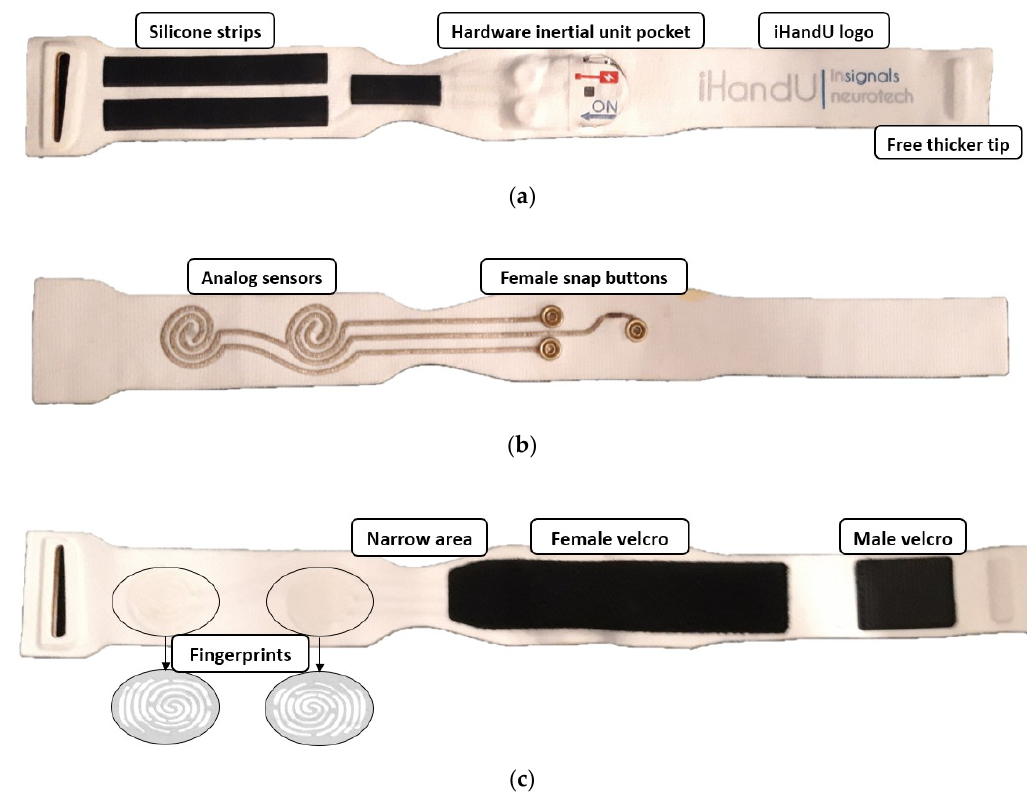
Figure 12. Textile band adaptation with new details to be suitable for the iHandU system. ( a ) Inside layer; ( b ) Middle layer; ( c ) Outside layer. layer; ( b ) Middle layer; ( c ) Outside layer.